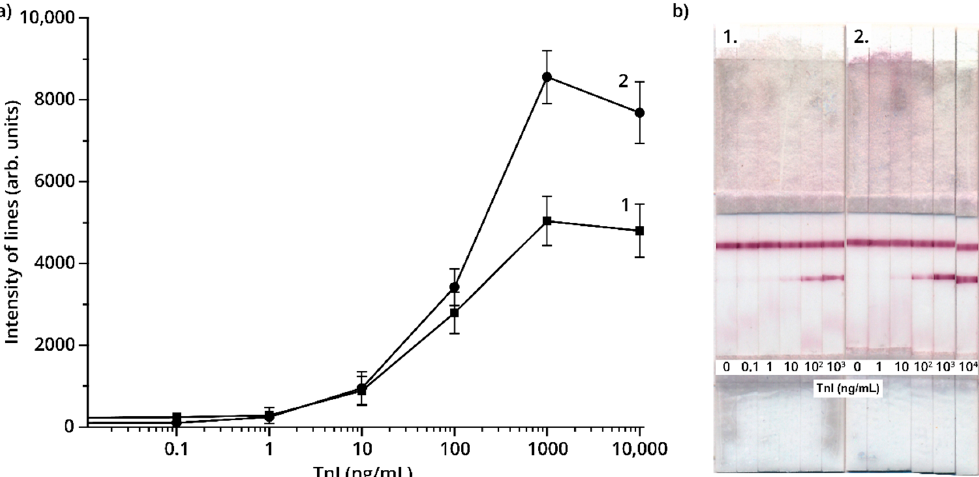
Figure 4. ( a ) Analytical zone intensity (arb. units) vs. TnI concentration using two LFIA variants; ( b